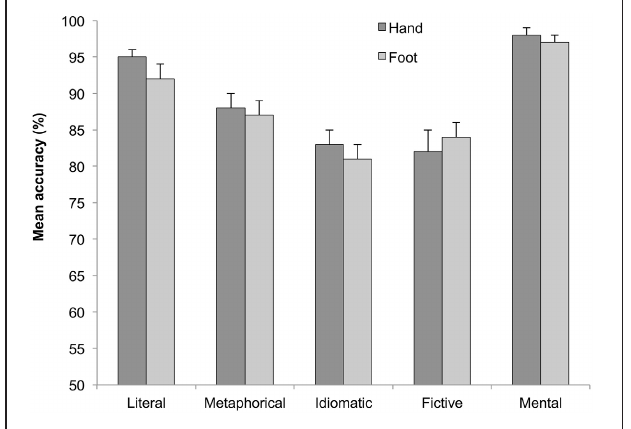
FIGURE 2 | Mean percentage of correct responses emitted with hand (dark gray bar) and foot (bright gray bar) effectors in literal, metaphorical, idiomatic, fictive motion, and mental sentences.